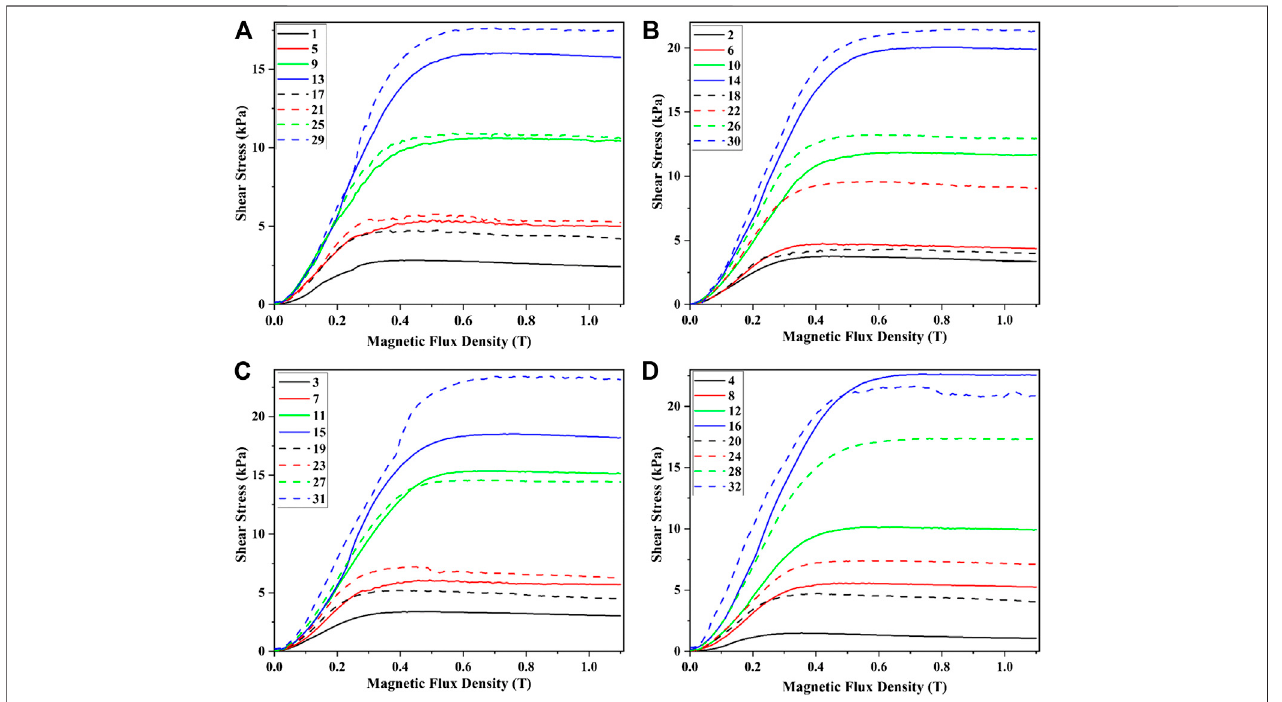
FIGURE 2 | The shear stress varies with the magnetic fl ux density under different content of surfactants and CI particles.